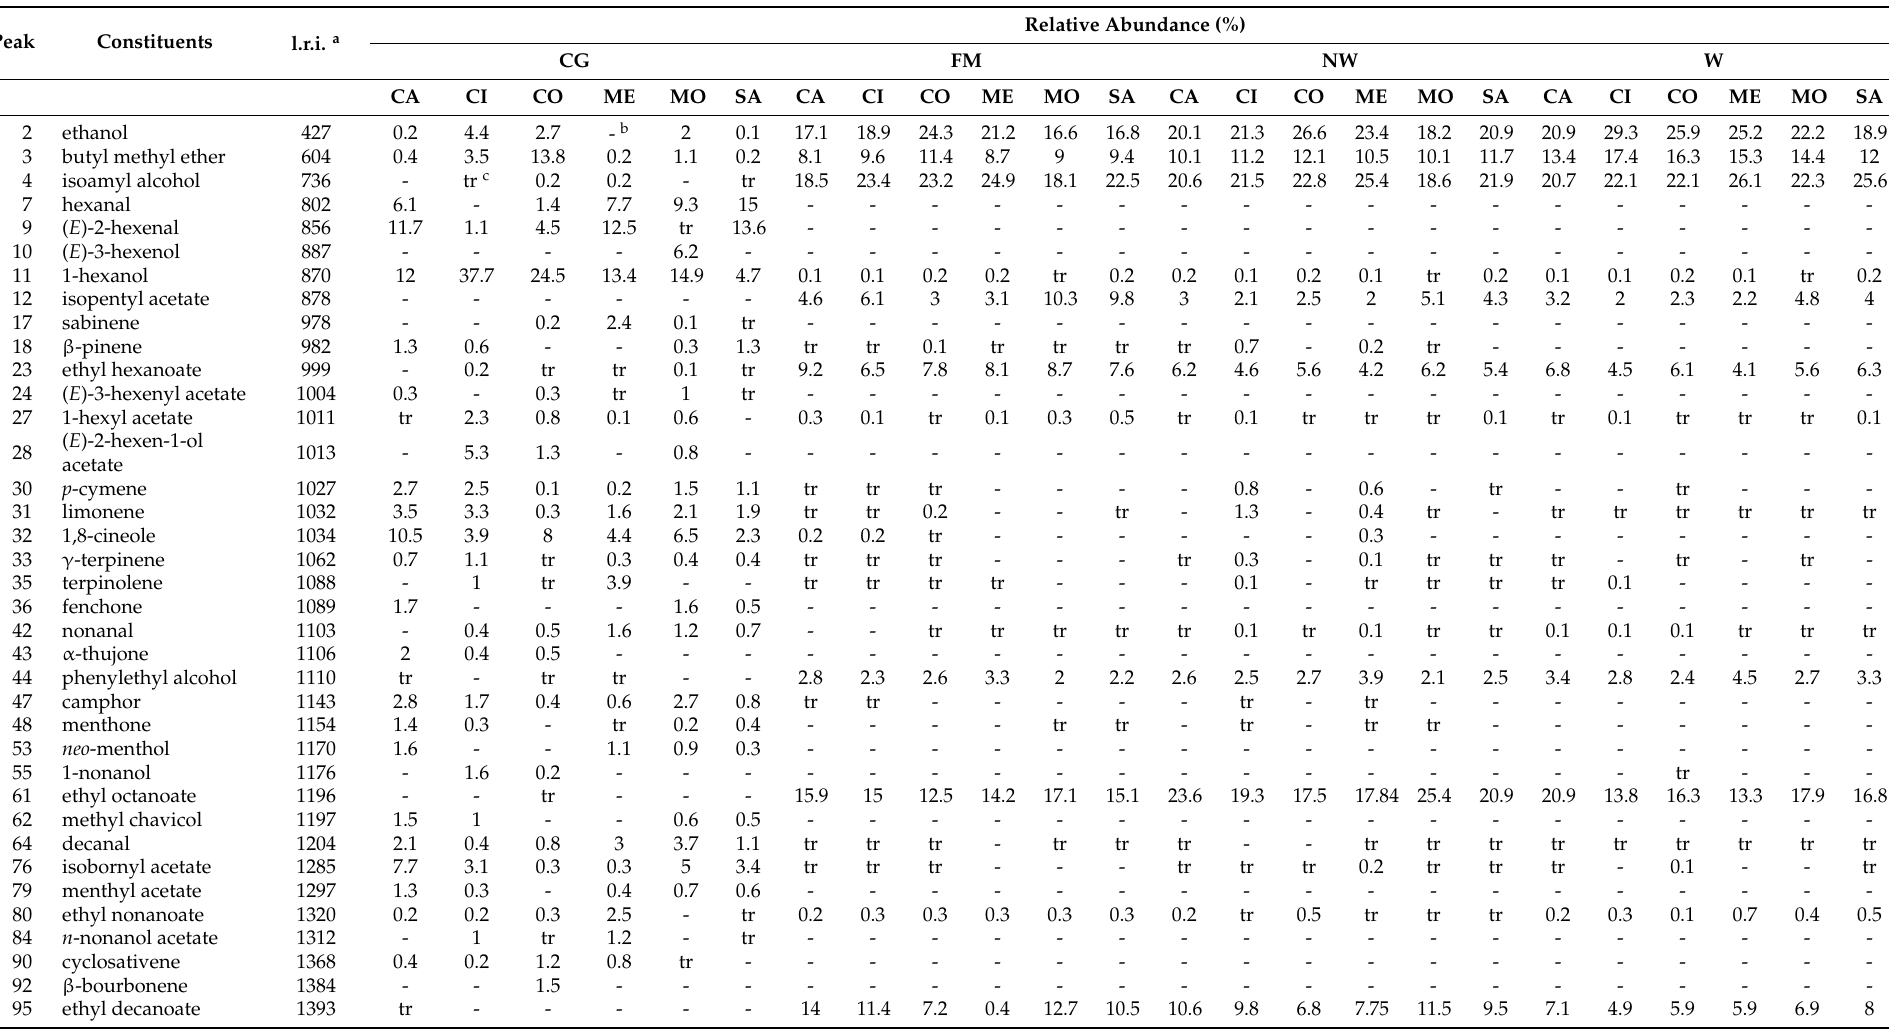
Table 1. Headspace compositions of all the analysed vinification phases of the six cultivars, reporting only compounds detected in amounts higher than 1% in at least one